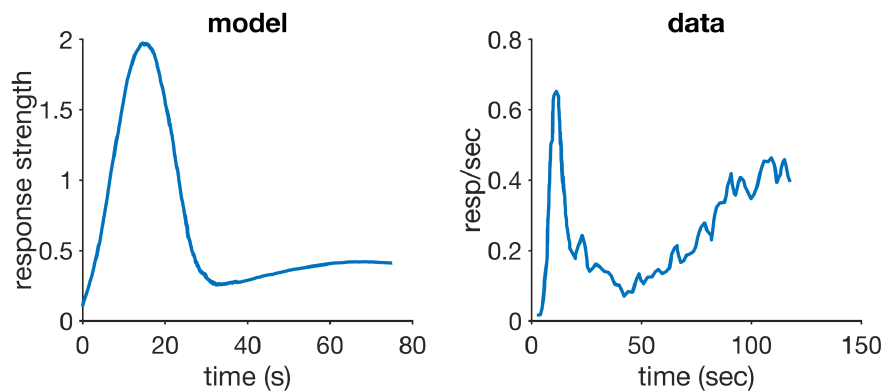
Fig 12. Mixed FI. Left: simulatedresponsestrength duringlong trials. Right: response strength data from a mixed FI experiment, redrawnfrom Figure 3 in [104]. Model parameters: α t = 0.2, α V = 0.1, μ = 1, σ = 0.425, m = 0.2, H =